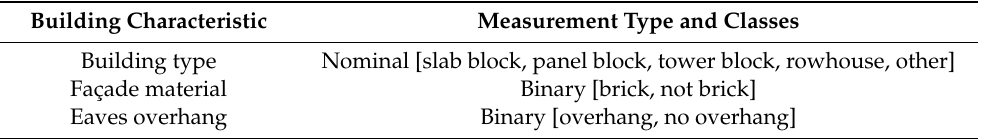
Table 4. Building characteristics that were observed in Google Street View and their respective measurement type.